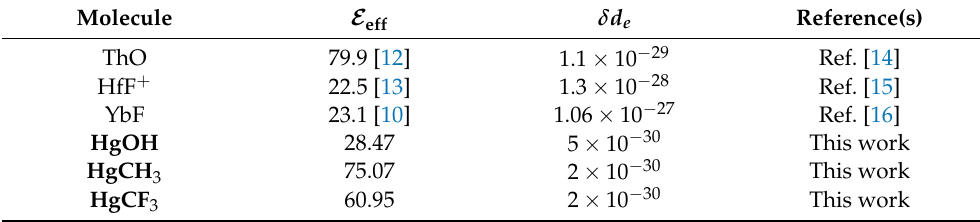
Table 5. Comparison of measured (ThO, HfF + , and YbF) and projected sensitivities (from appropriate references as given in the table) offered by different molecules for EDM experiments. For molecules where measurements are not available, the sensitivity is estimated with appropriate N , T , τ , and η values. The unit chosen for δ d e is e-cm, while the effective electric field is given in GV/cm. Molecule E eff δ d